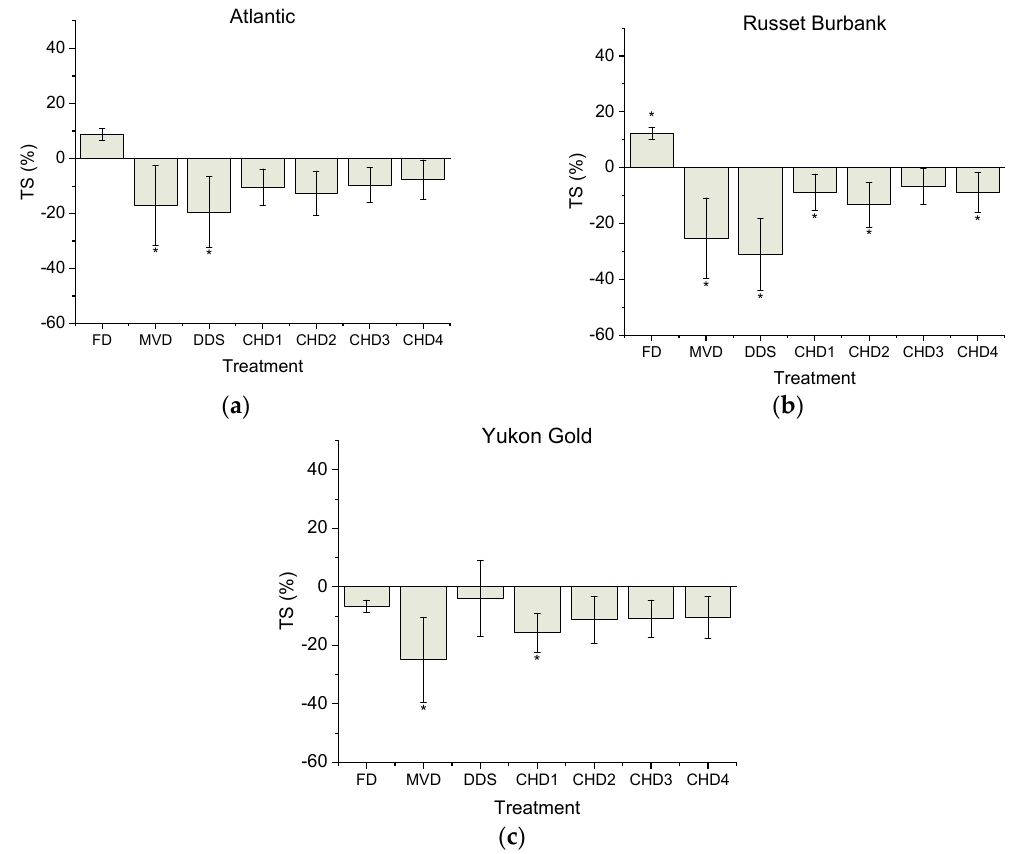
Figure 3. Total starch (percent difference) compared to fresh controls for Atlantic ( a ), Russet Burbank ( b ) and Yukon Gold ( c ) potato cultivars. Baseline TS content of freshly cooked controls were 78.52 ± 3.32, 72.65 ± 0.93 and 76.90 ± 1.90 (g/100 g DW) for ALT, RB and YG respectively. Different drying treatments were assessed and compared to a fresh control using Dunnett’s test. Data is presented as mean ± SEM. For each genotype, * indicates statistically significant ( p < 0.05) difference in comparison to control (fresh).